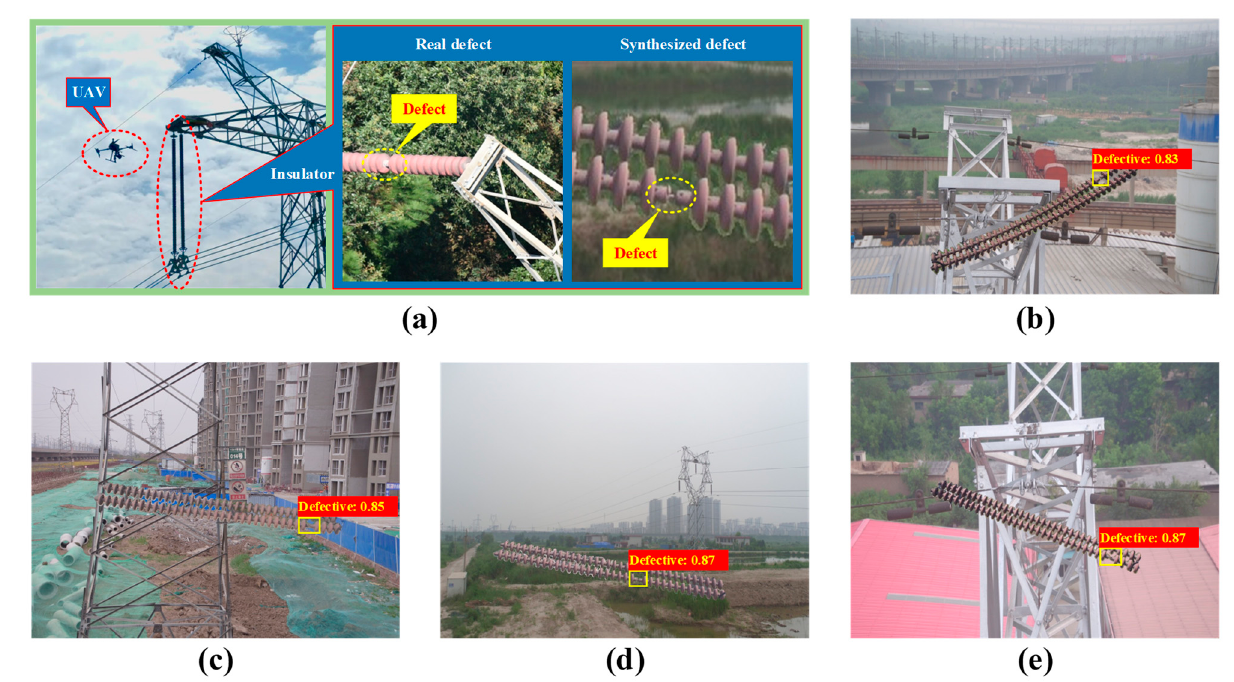
Figure 10. An example of the detection of defective insulators using our model: ( a ) the schematic of the insulator defect detection and its images; ( b – e ) the identification effect of different defective insulators synthesized with ground-truth images. Table 3. Performance comparison of the proposed model and original YOLOv5s in the image-based insulator defect detection.